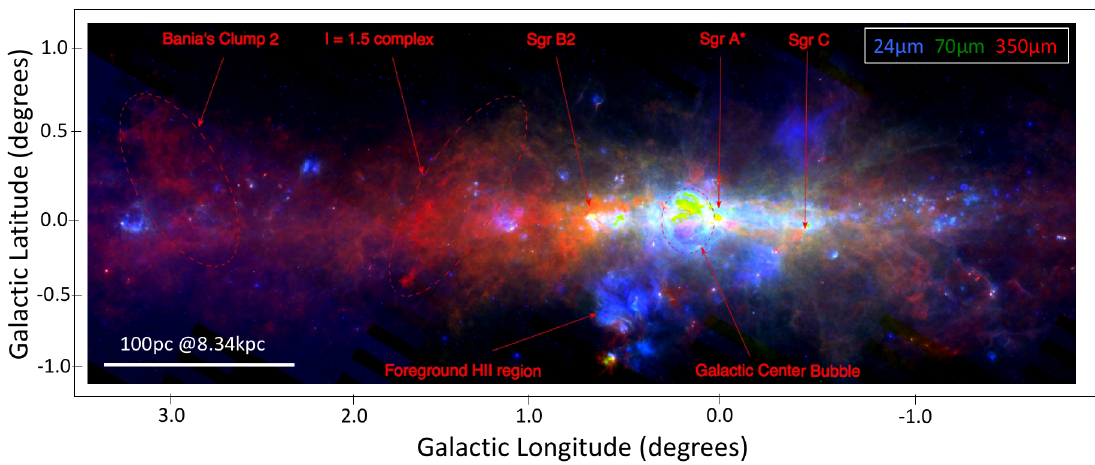
Figure 1. Three-colour image of the inner few degrees of the Milky Way around the Galactic Centre at sub-mm to mid-IR wavelengths (following [11,12]). Red and green show 350 µ m and 70 µ m emission ( Herschel Hi-GAL [13]) and blue shows 24 µ m emission ( Spitzer MIPSGAL [14]). Sources of interest throughout the region are labelled. The scale-bar shows a projected length of ∼ 100pc at a distance of 8.34kpc [15]. As the largest concentration of dense gas in the Galaxy by far and the site of some of the most extreme star formations in the Galaxy, the inner few hundred pc of the Galactic Centre is very bright in (sub)-mm continuum emission from dust associated with the gas (red), and mid-IR emission from dust heated by recently formed high-mass stars